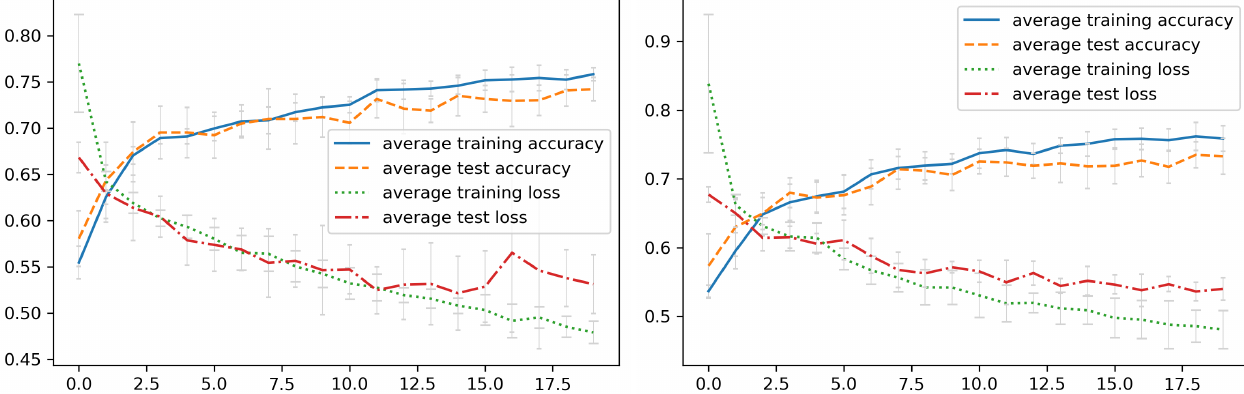
Figure 15. Left image: single dropout. Right image: double dropout. Summary of average results for 20 iterations. Class 0 vs. I. Single dropout. Model: the LeNet model from Figure 5 was applied. Cross-validation 5. Accuracy for 20 iterations of neural network training and corresponding cross-entropy